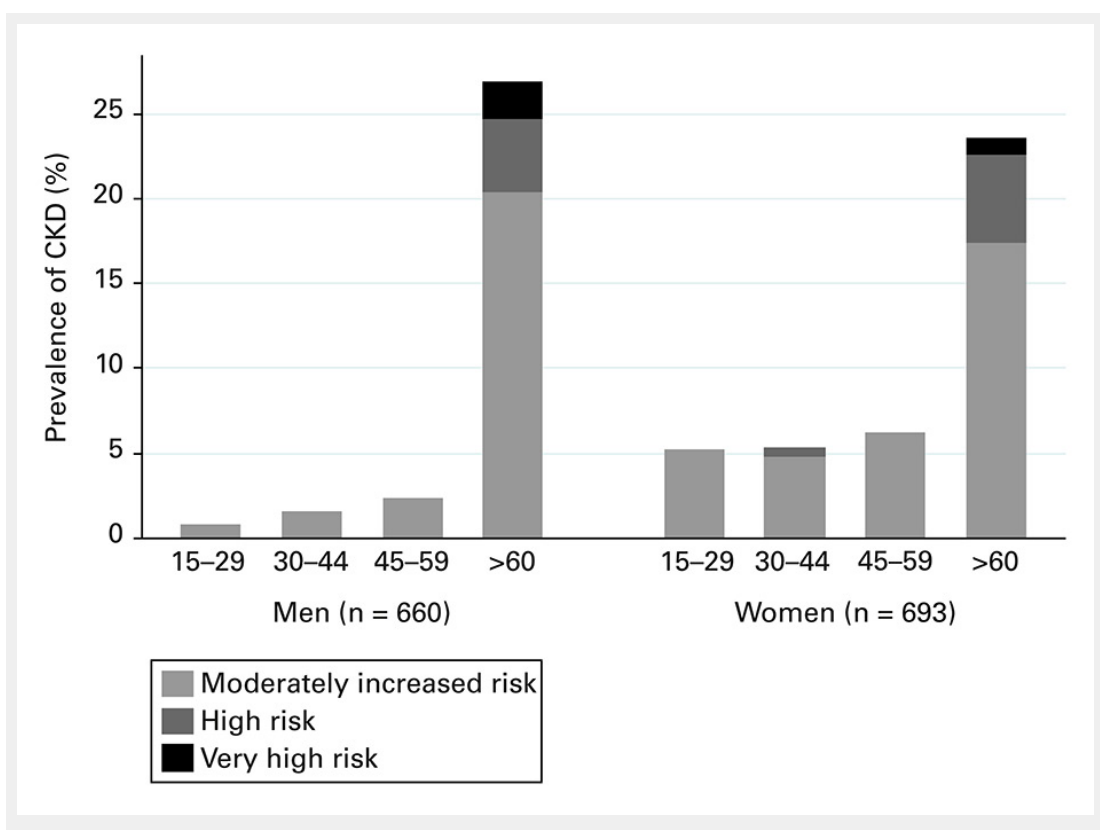
Figure 2 Prevalence of chronic kidney disease (KDIGO 2012), by gender and age category. p-values are from a nonparametric test for trend, comparing the trend in combined medium- to very high-risk categories vs low-risk category across age groups KDIGO = Kidney Disease – Improving Global